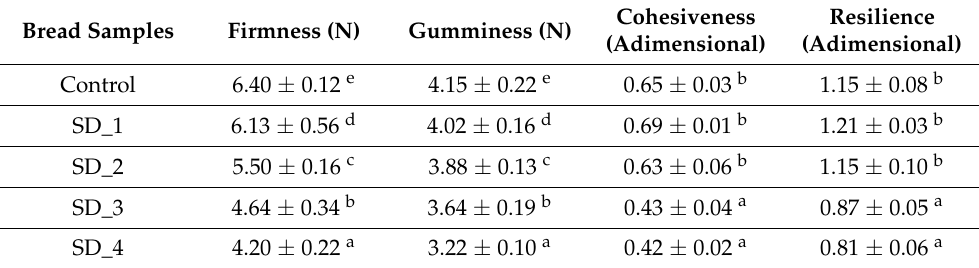
Table 7. Texture parameters of bread samples with different levels of dry sourdough (SD)